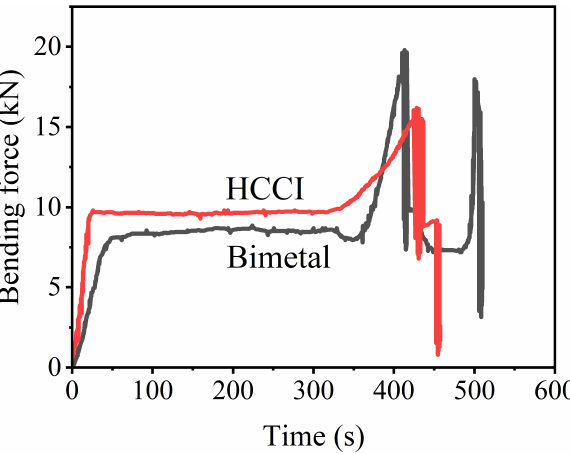
Figure 16. Bending force vs. time curves of the bimetal and HCCI.